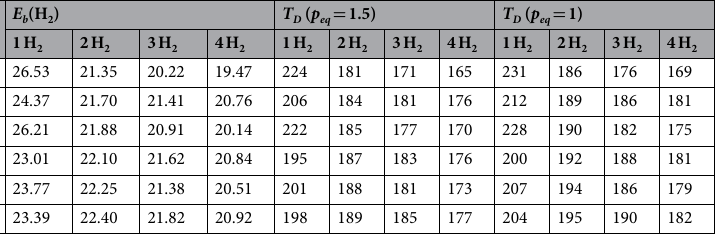
Table 1. Average H 2 binding energy E b (H 2 ) (kJ/mol per H 2 ) and H 2 desorption temperature T D (K) for Li 2 C n ( n = 5–10) with x H 2 molecules ( x = 1–4) adsorbed on each Li atom, calculated using TAO-BLYP-D. Here, T D is estimated using the van’t Hoff equation (see Eq. (5)) at p eq = 1.5 (bar) and at p eq = 1